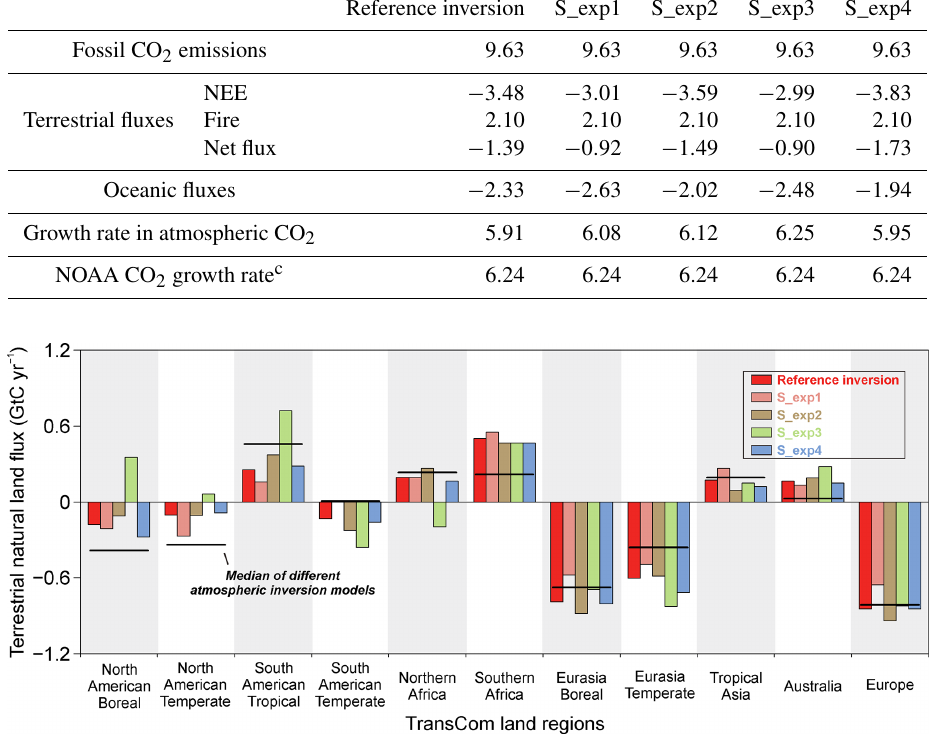
Figure 9. Terrestrial natural land fluxes over the 11 TransCom land regions derived from sensitivity inversions for 2015. The results of the reference inversion and four sensitivity inversions (please see Table 2) are represented by bars denoting the posterior natural land fluxes (i.e., terrestrial biospheric + fire fluxes) in 2015 for each TransCom land region; the black lines represent the median values of all six inversion estimates shown in Fig. 5 over the corresponding region and